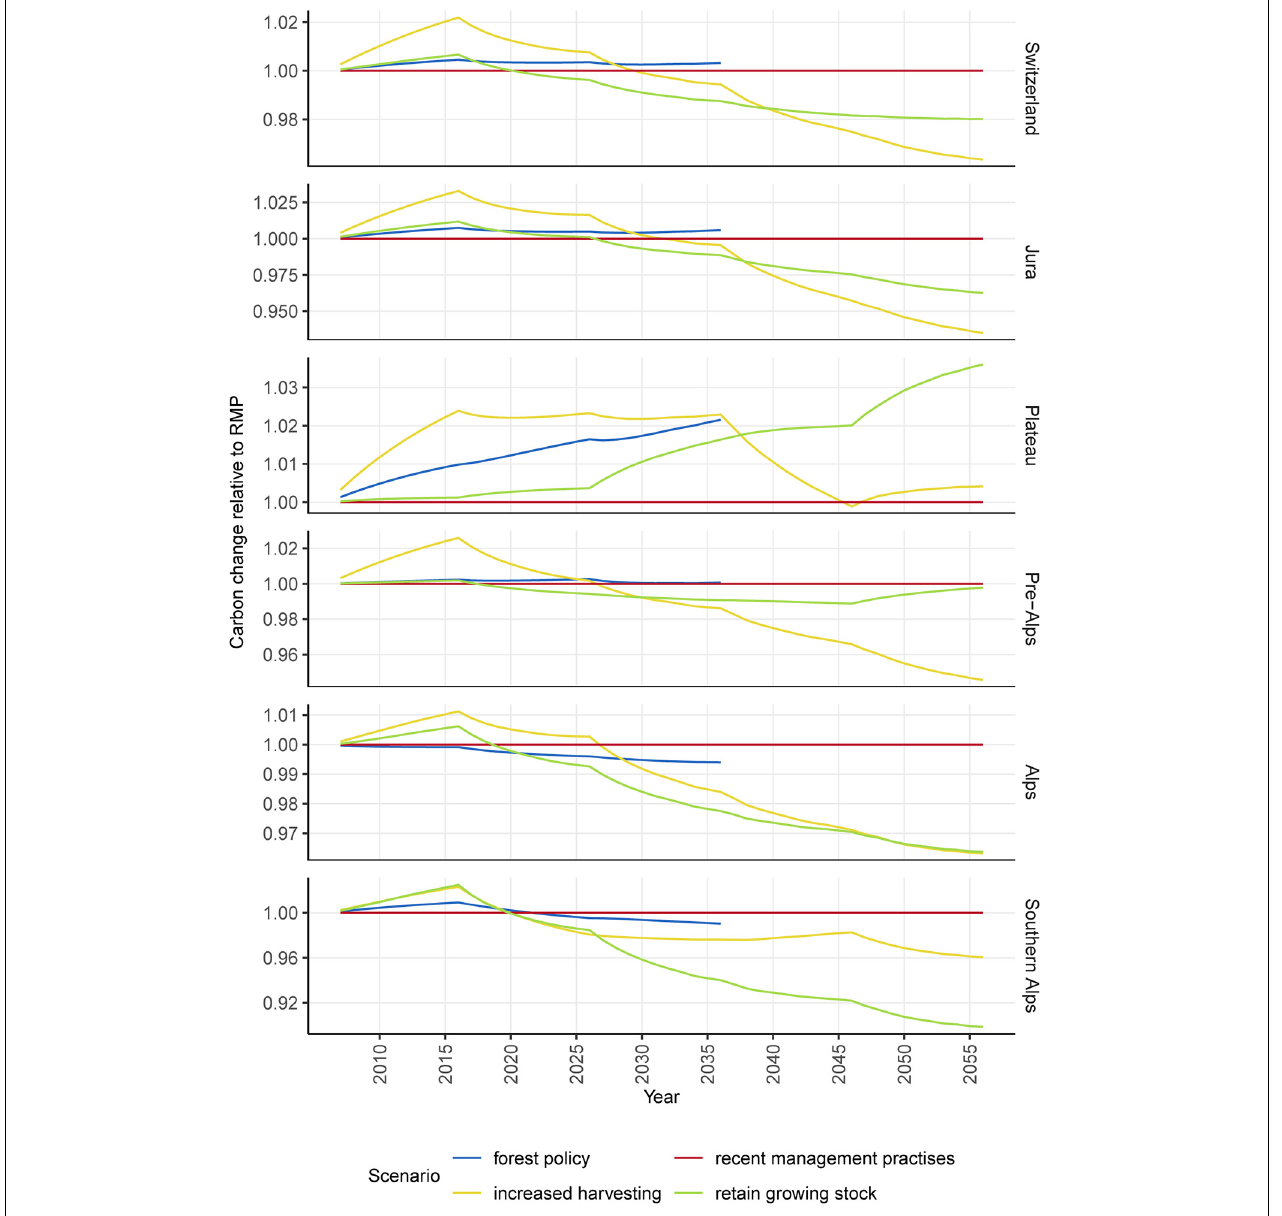
FIGURE 5 | Carbon stock relative to the recent management practices (RMP) scenario. Values above 1 indicate higher combined dead organic matter (DOM) and soil carbon stocks than in RMP and vice